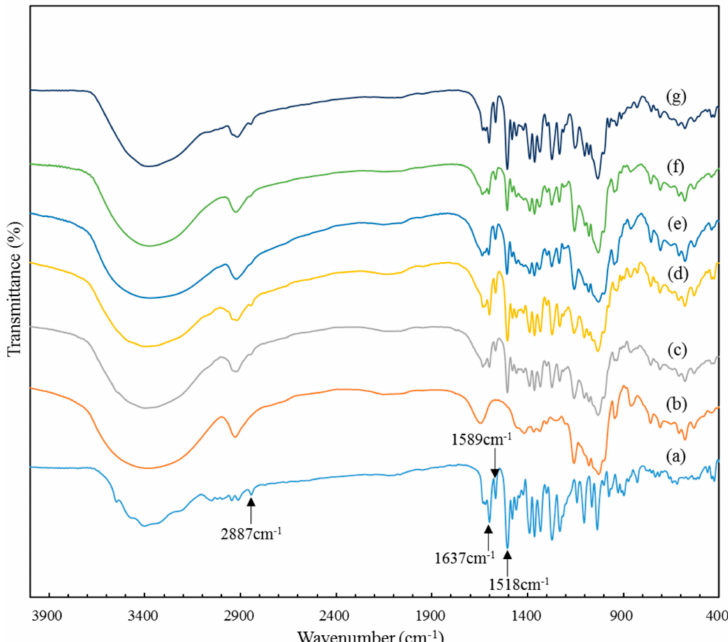
Figure 4. Infrared reflection spectra of ( a ) BBR; ( b ) raw β -cyclodextrin; ( c ) physical mixture (1:1, n / n ); ( d ) ICB; ( e ) (BP m Sample 7; ( f ) BP n Sample 2#; ( g ) BP mix Sample